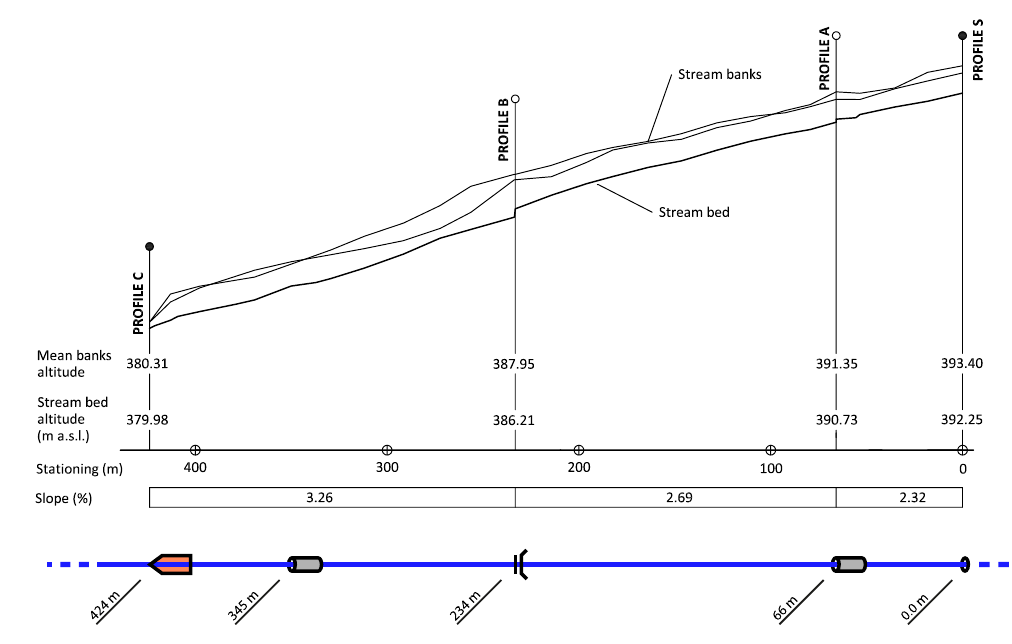
Figure 2. Stream longitudinal profile with monitoring sites and culverts on the Nuˇcice experimental catchment.